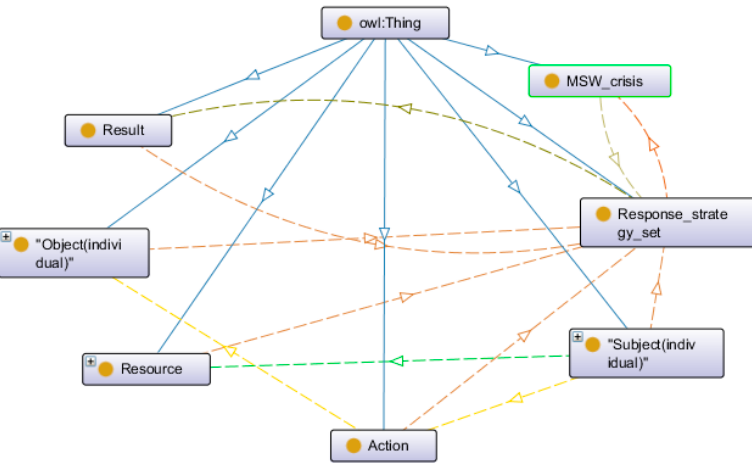
Figure 6. The conceptual model of response strategy ontology.